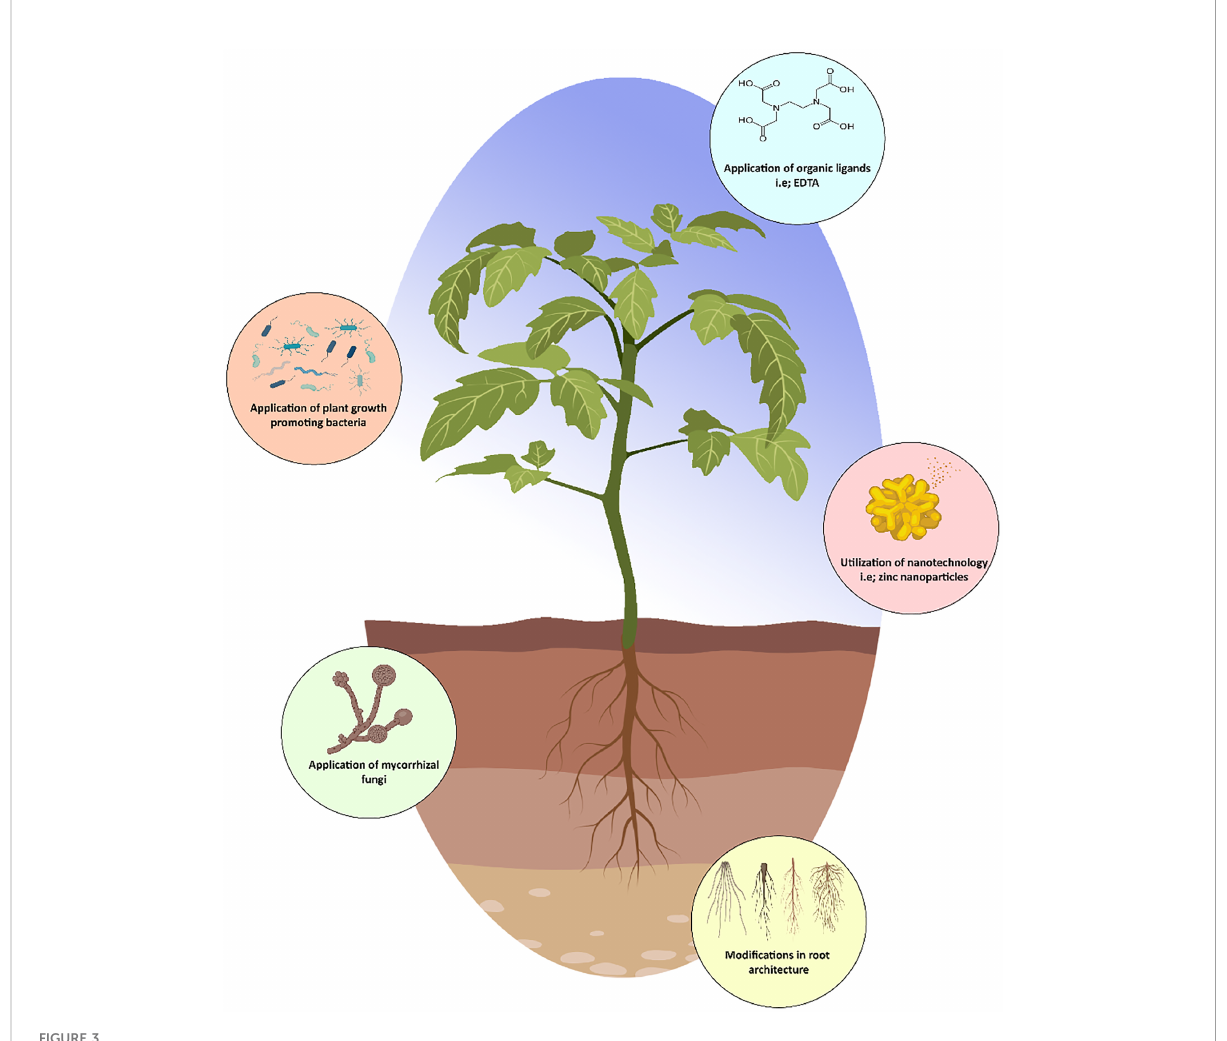
FIGURE 3 Strategies to enhance zinc uptake in